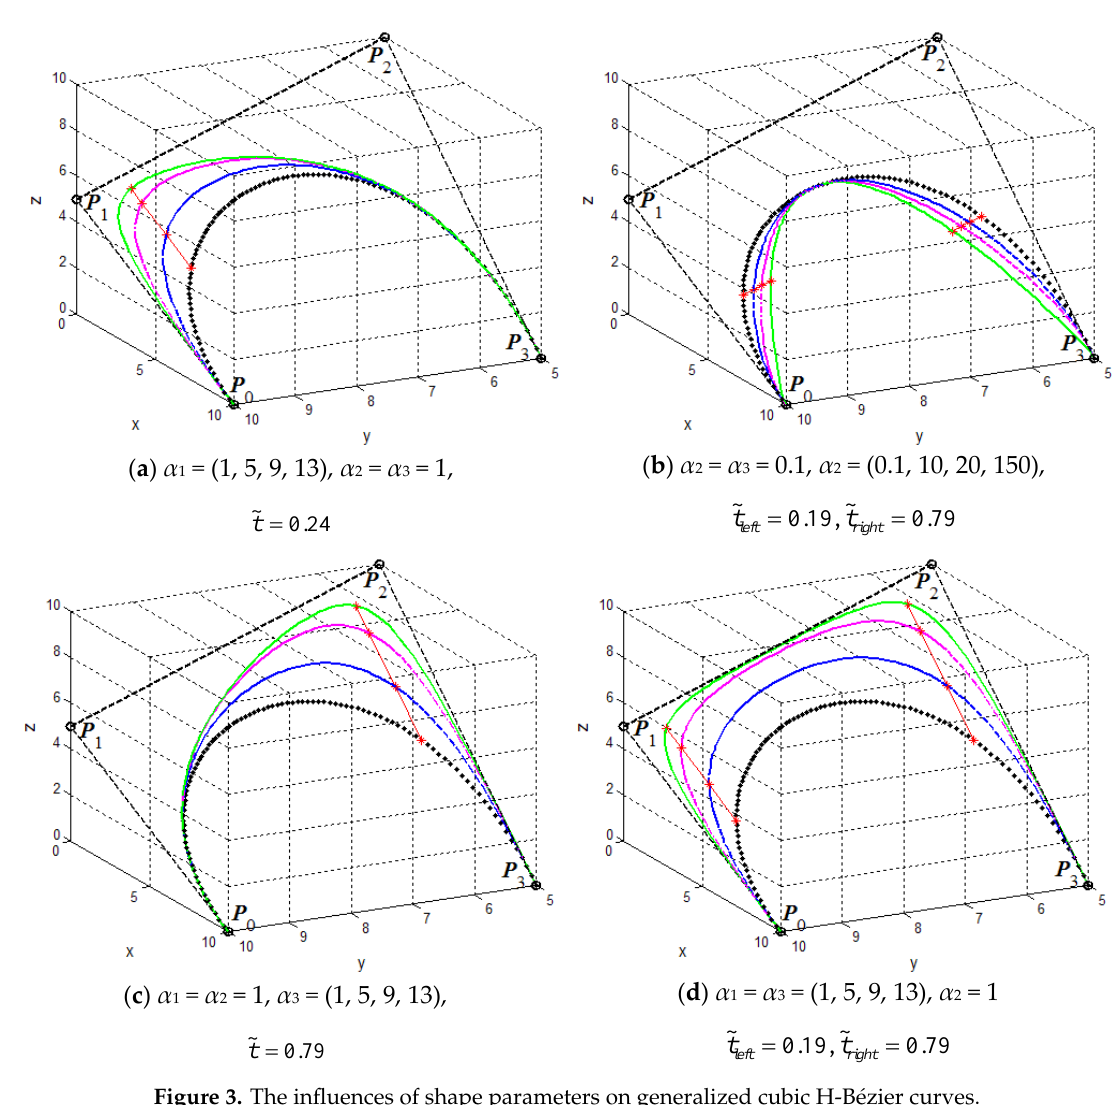
right in parentheses corresponding to the H-Bézier curves from the black dotted curve to the green